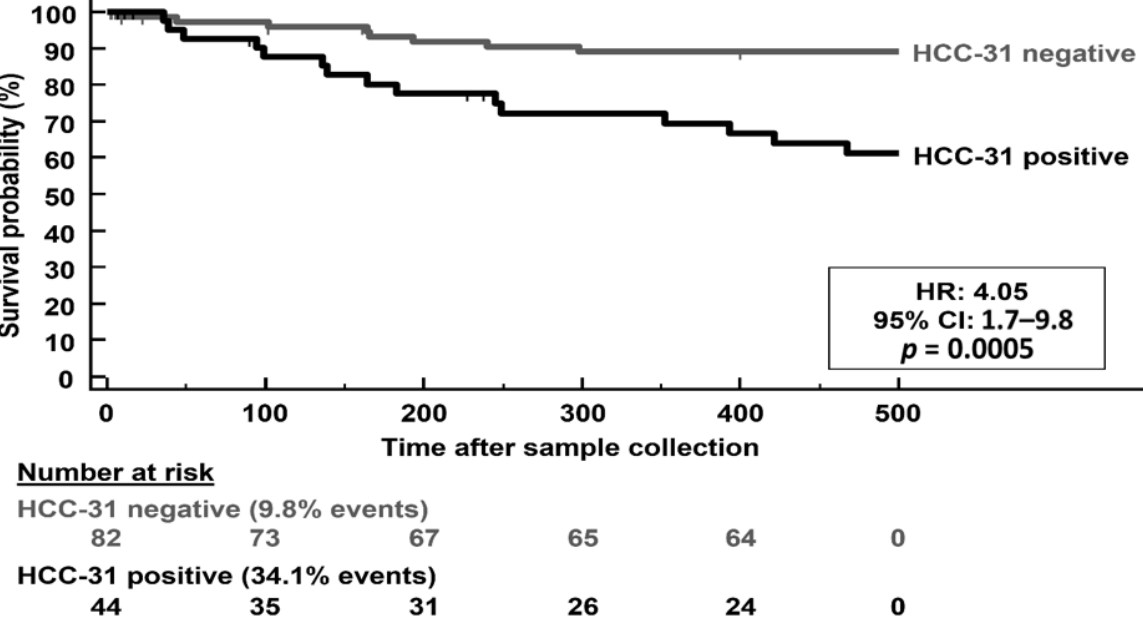
Figure 2. Overall survival of patients with a positive or negative HCC-31 test result during a follow-up of 500 days starting from the date of urine sample collections. Patients lost to follow-up were censored.